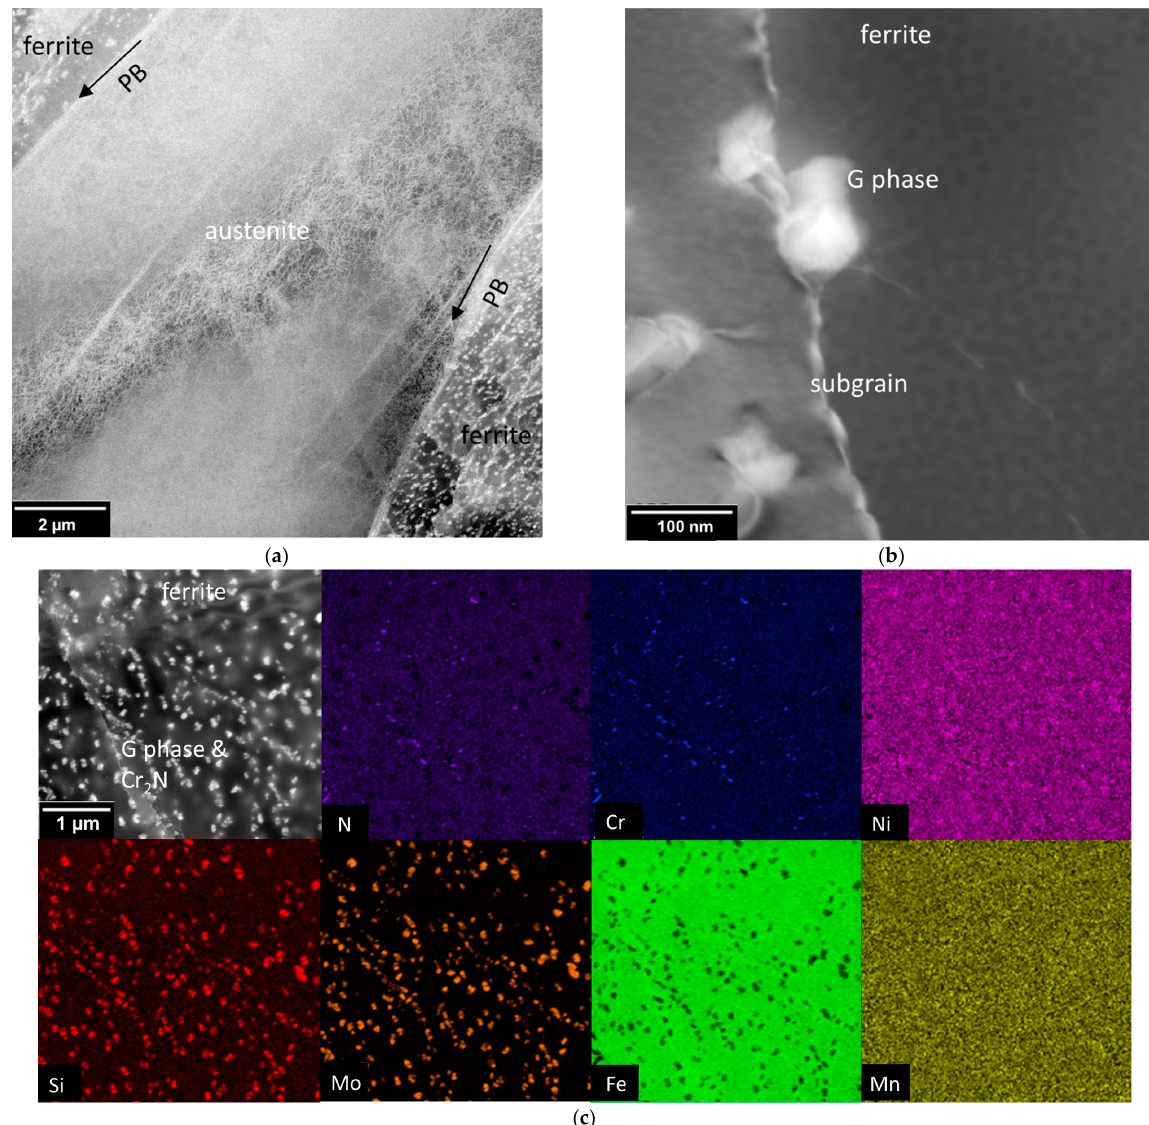
Figure A6. Detailed STEM images of the dislocation arrangement in austenite ( a ), and precipitates in ferritic grain ( b , c ) STEM-ADF image of precipitates in ferrite and the corresponding EDX mapping of the elements N, Cr, Ni, Si, Mo, Fe and Mn after thermomechanical fatigue in OP condition. Table A1. Yield strength R 0.2 , max. tensile strength R m and the elongation at fracture A of isother-